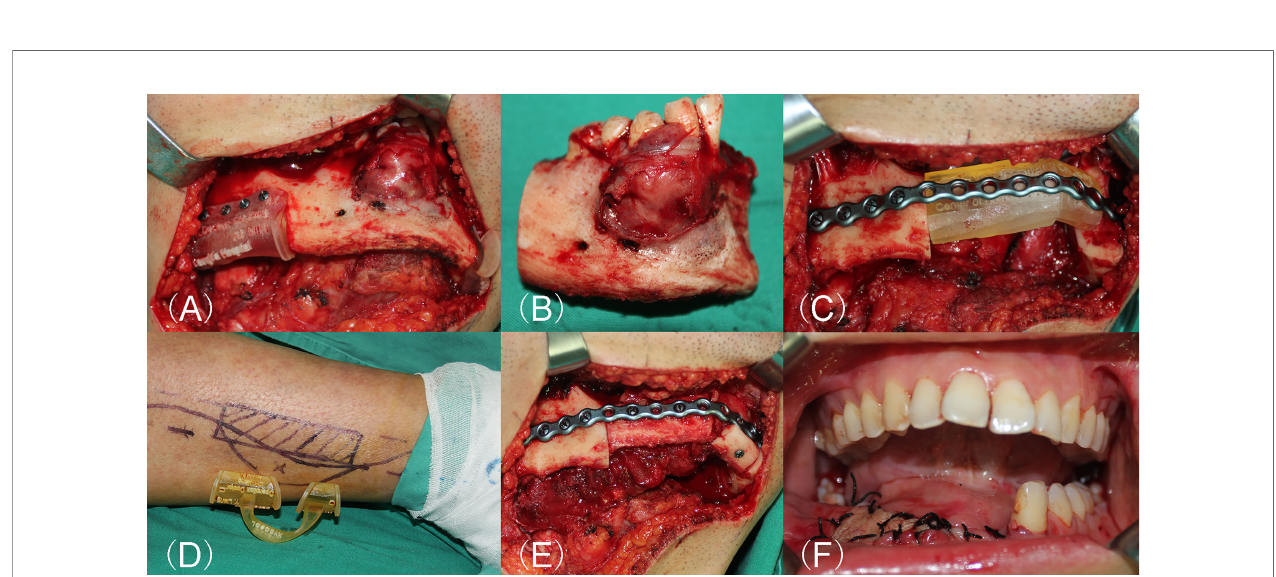
FIGURE 5 | Surgical procedure of CORPPP-guided mandibular reconstruction. (A) Placement of the resection guiding templates with the designed fi xing holes and screws. (B) Mandibular lesion specimen after segmental resection. (C) Placement of the pre-shaped titanium plate with the designed fi xing holes. (D) Design of the fi bular fl ap. (E) Fixation of fi bula segments into the defect.